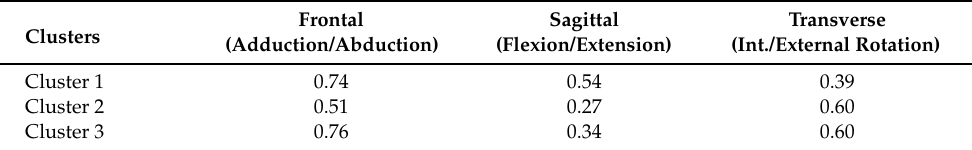
Table 2. Intracluster correlation coefficient (ICC) using the global representation. Clusters